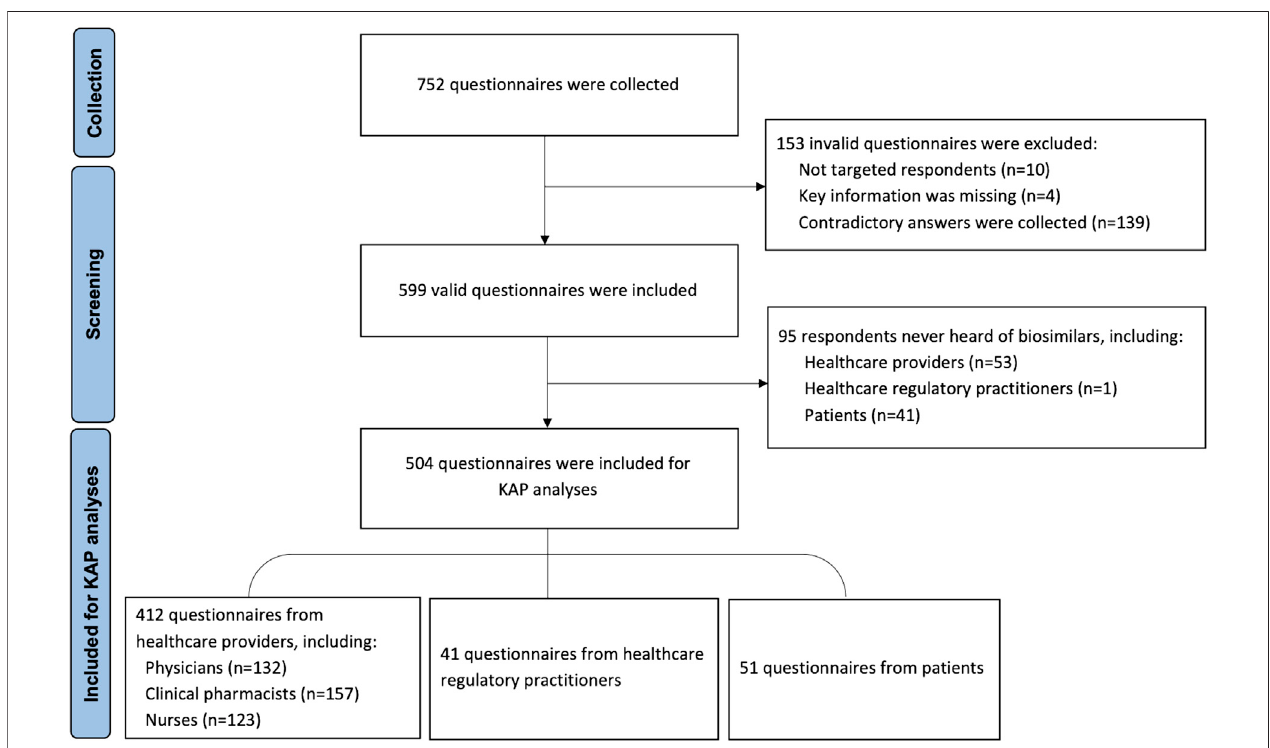
FIGURE 1 | Flow diagram of including and excluding the